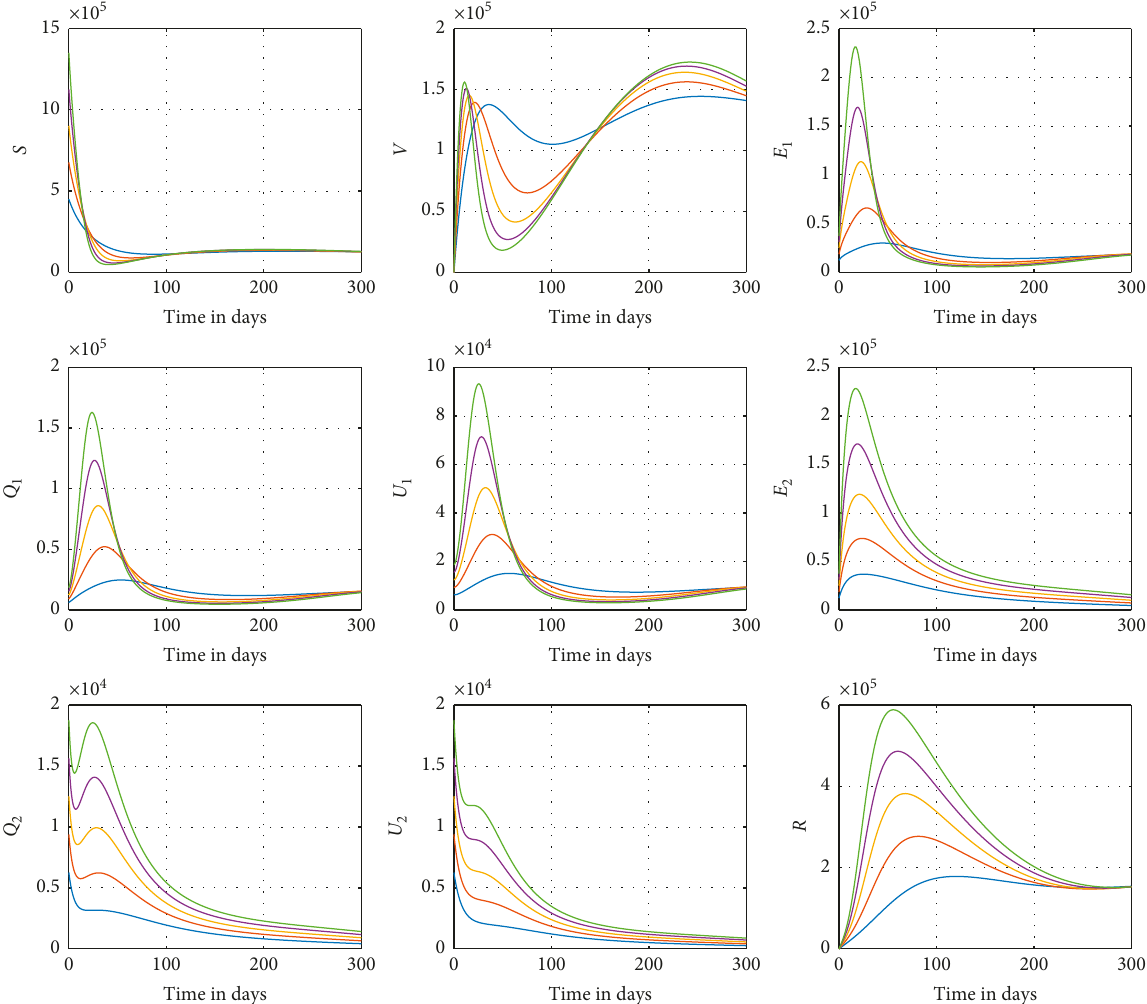
Figure 4: These graphs are obtained by numerically solving model 1 using parameter values as contained in Table 1. With this choice of � ψ � 0 . 1, α � 0 . 6/ N parameter values ψ , η � 0 . 7/ N , and R c � 1 . 8883, where S is the susceptible individuals, V is the vaccinated 0 0 1 2 is the individuals exposed to variant 1, Q is the quarantined individuals who are infected with variant 1, U is the undetected individuals, E 1 1 1 individuals who are infected with variant 1, E is the individuals exposed to variant 2, Q is the quarantined individuals who are infected with 2 2 is the undetected individuals who are infected with variant 2, and R is the recovered variant 2, U 1 increase in the population infected with variant 1. This is Figure 6 that, with increase in the rate at which individuals probably because individuals infected with variant 2 infected with variant 1 escape the isolation center, vac- appear to be more careful with their lives and get vac- cination of susceptible individuals lowers the peak of the cinated more than individuals infected with variant 1. population infected with variant 2 while there is an